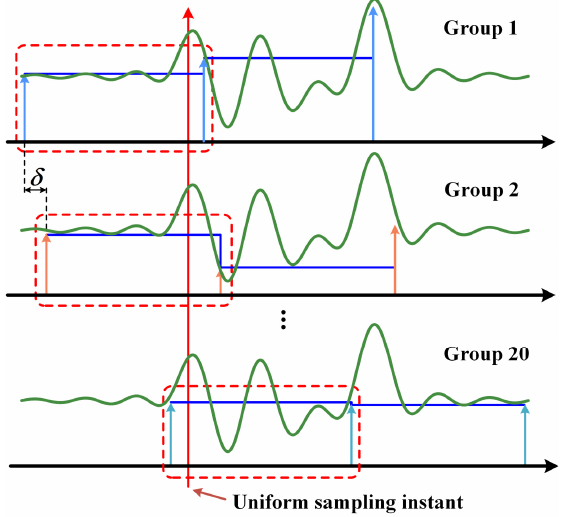
Figure 7. Schematic diagram of the uniform sampling by the electronic ADC (green line: input signal; colored short arrow: sampling instants for different groups of low-speed uniform optical pulse train; blue line: waveform from the T/H circuit; red box: nonuniform sampling period; red long arrow: sampling instant for the electronic